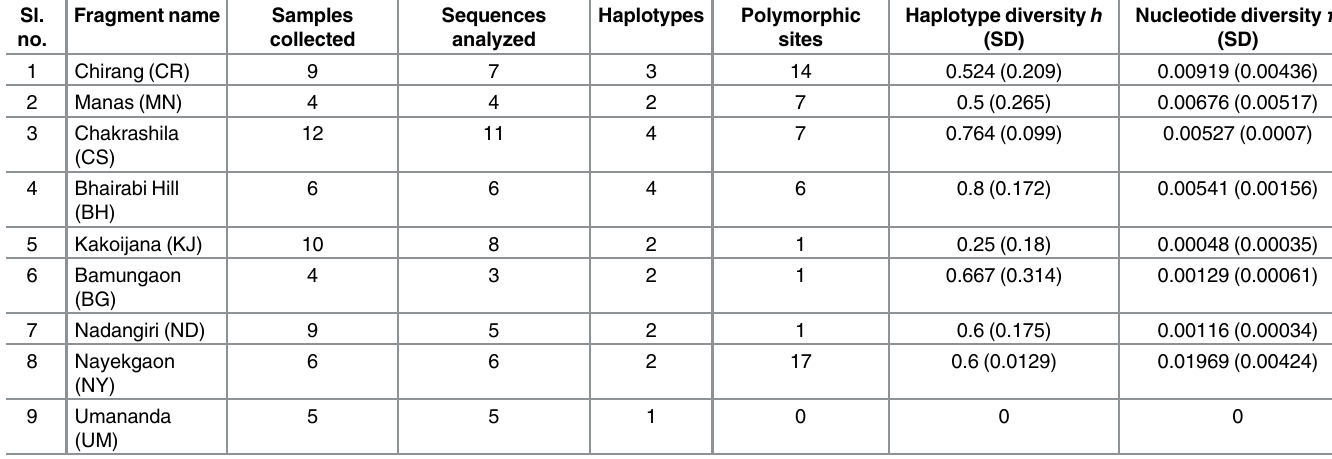
Table 2. Fragment-wise estimates of genetic diversity in the golden